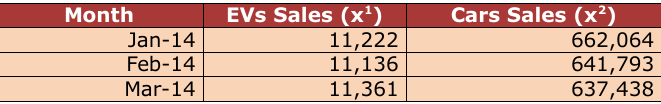
Table 3. The prediction values of EVs monthly sales and those of Car monthly sales from Jan. 2014 to Mar. 14 in